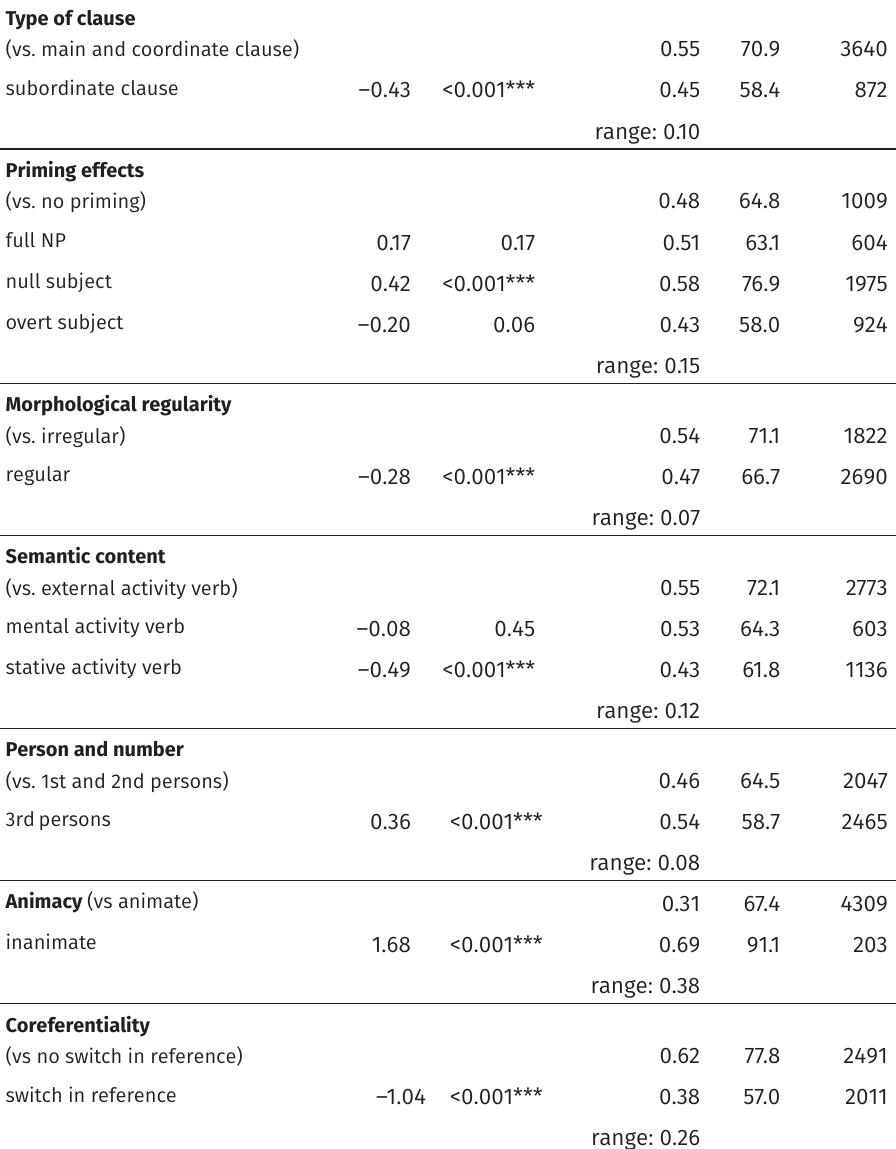
Table 18: Significant linguistic factors for the use of null subject with recoding (intercept = 1.54; N = 4512; [Ø] =